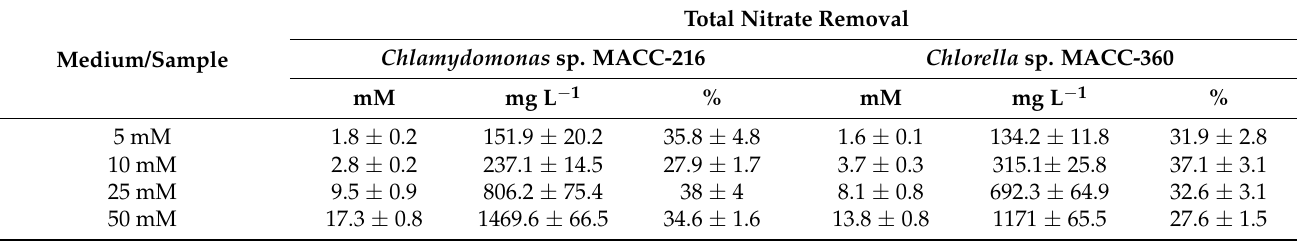
Table 4. Total nitrate removal by Chlamydomonas sp. MACC-216 and Chlorella sp. MACC-360 in SWW supplemented with 5 mM, 10 mM, 25 mM and 50 mM nitrate by 6 th day. Values are represented as mean ± SD.